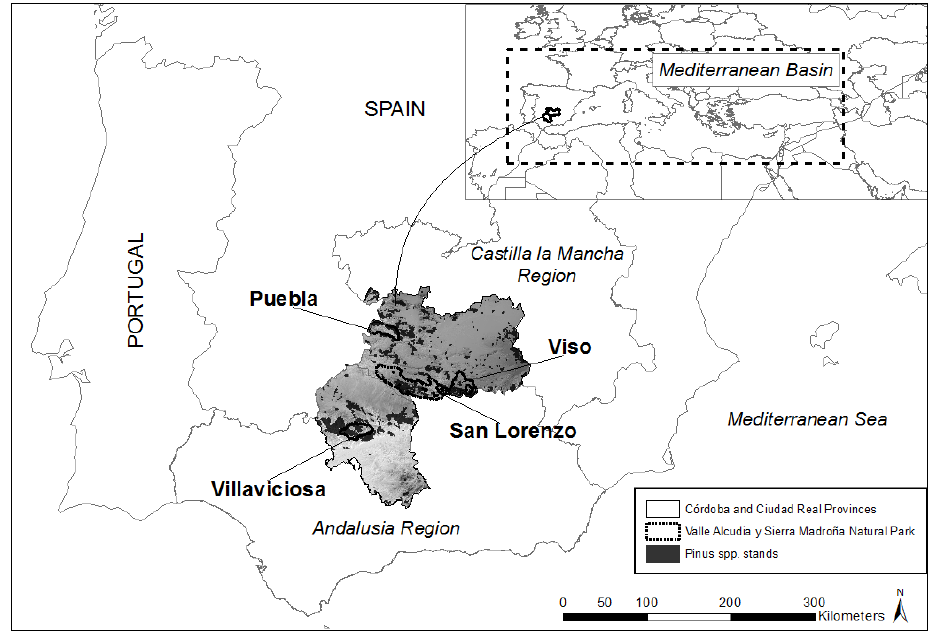
Figure 1. Study area location (shaded areas correspond to the two provinces, Córdoba and Ciudad Real).